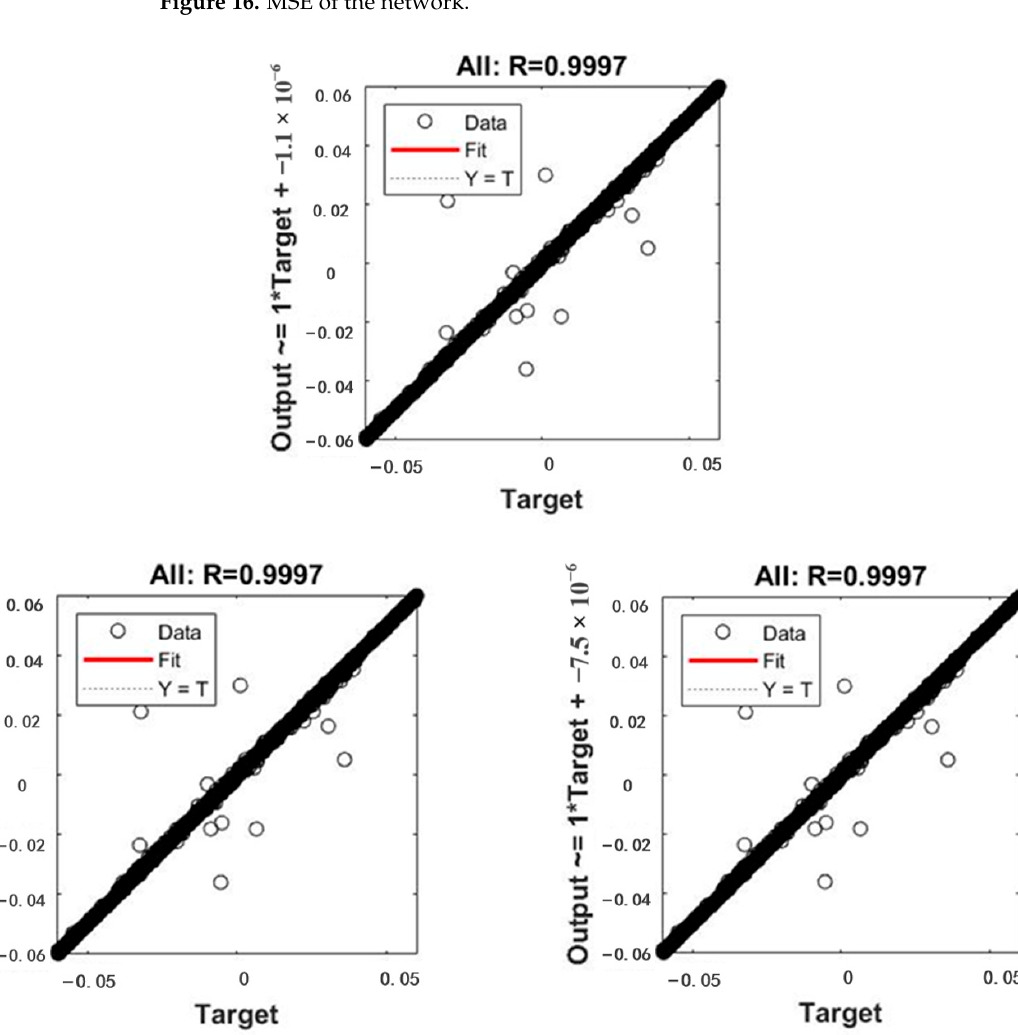
Figure 17. The R value of the network.